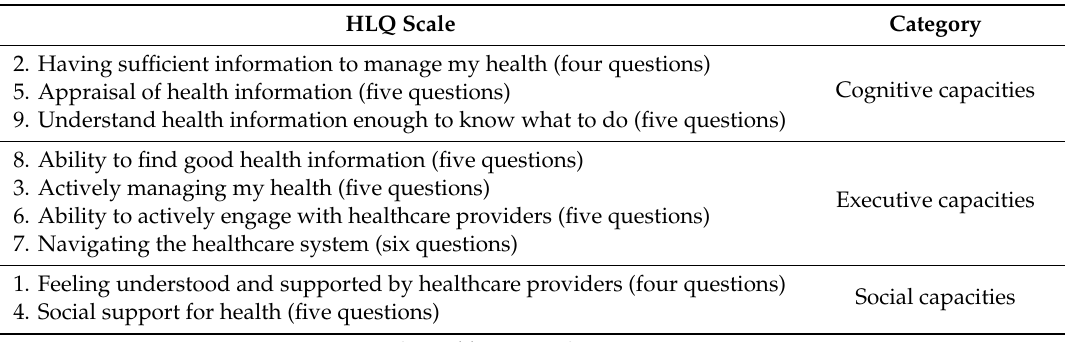
Table 1. The nine HLQ scales characterized by